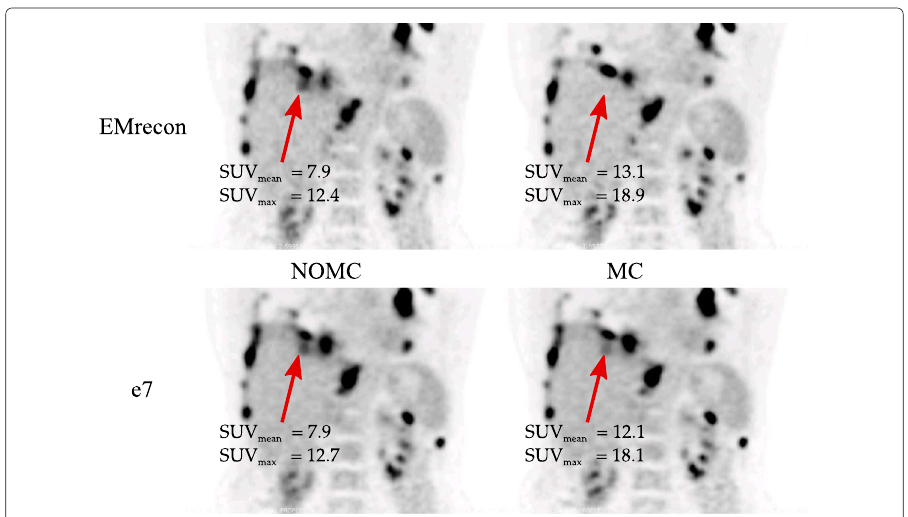
Fig. 8 Patient case #5 (coronal plane) showing NOMC and MC reconstructions. The arrow highlights motion correction